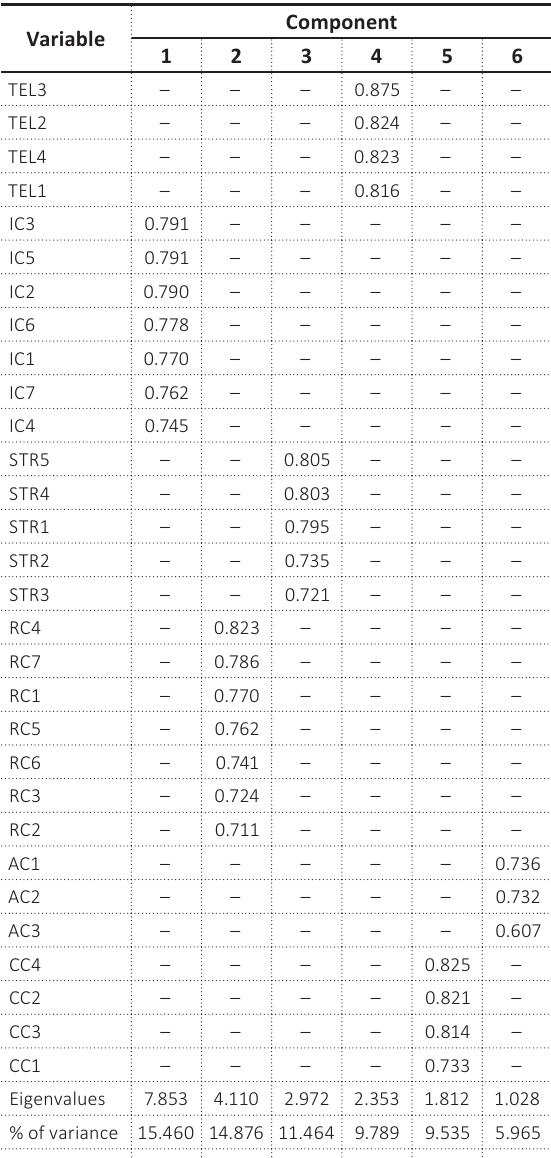
Table 4. Rotated component